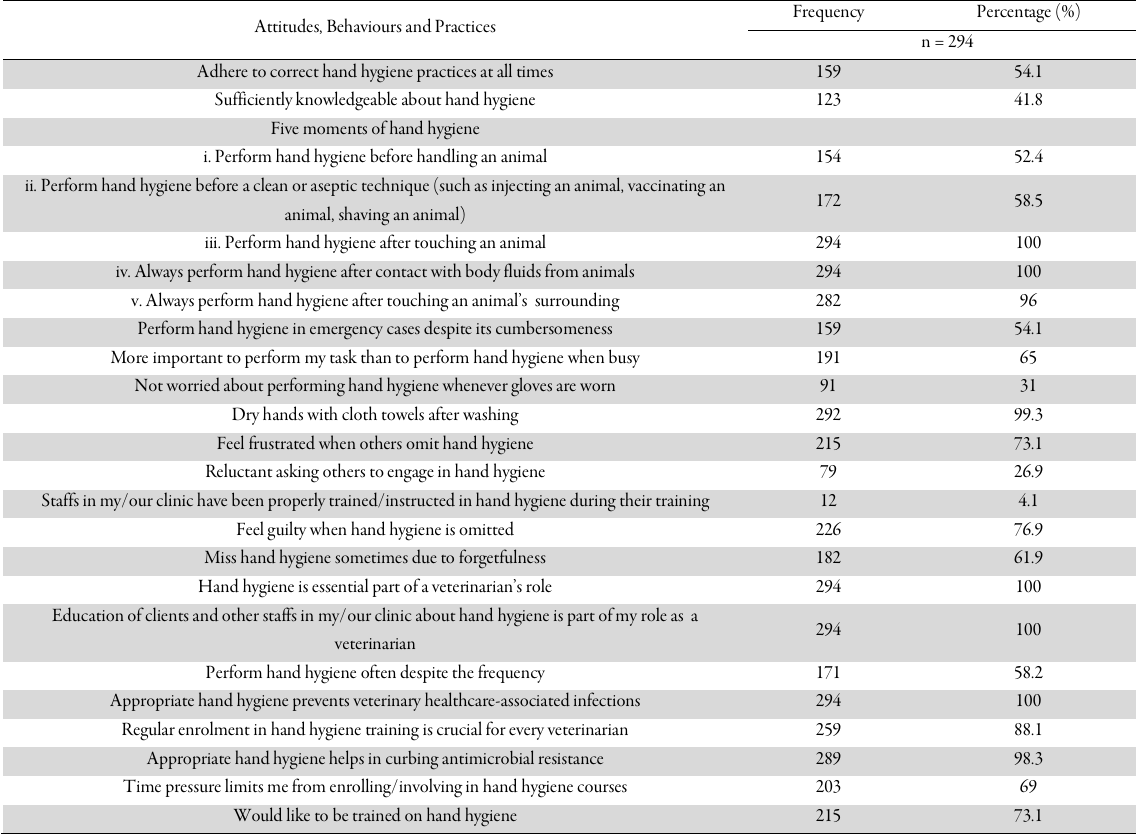
Table 3. Practices and attitudes of hand hygiene by veterinarians Attitudes, Behaviours and